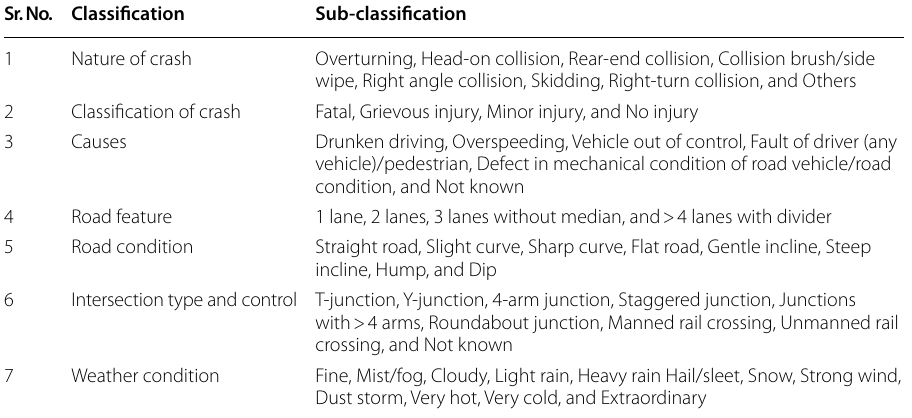
Table 2 Classification of crash data for statistical analysis Sr. No.